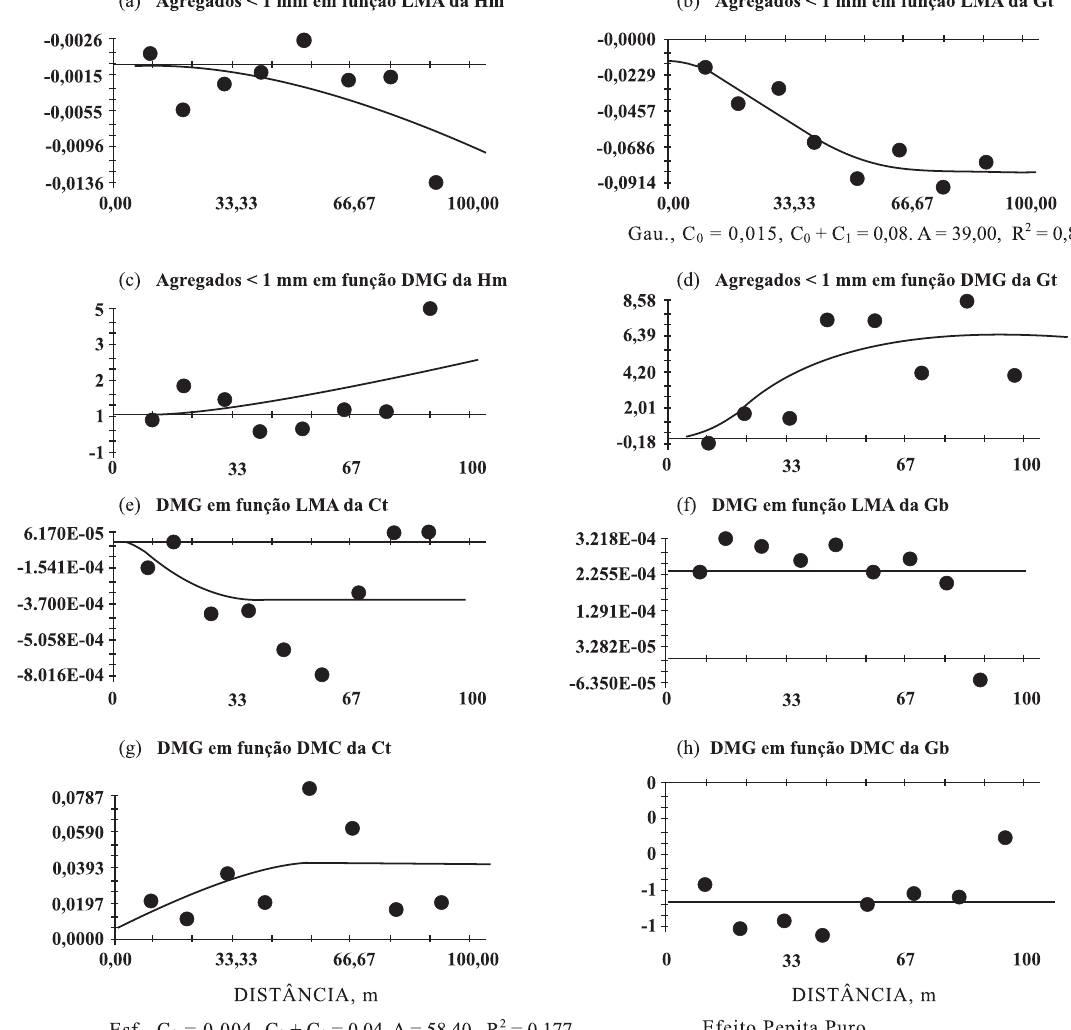
Figura 4. Semivariogramas cruzados dos atributos estudados. Gau.: gaussiano; Esf.: esférico; C